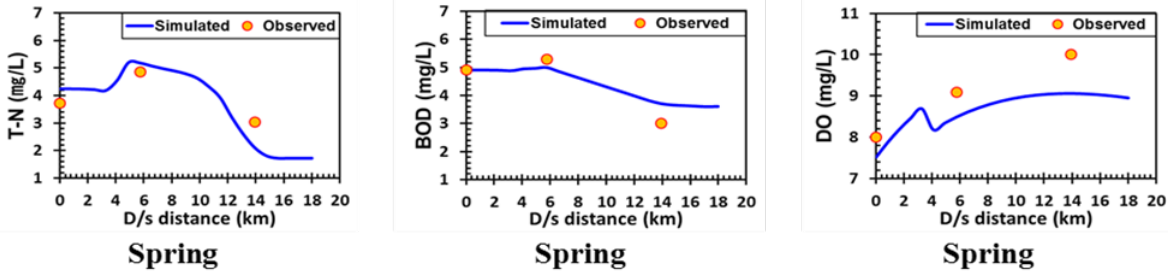
Figure 3. Calibration of water qualities in the Ara Waterway for the Spring season.